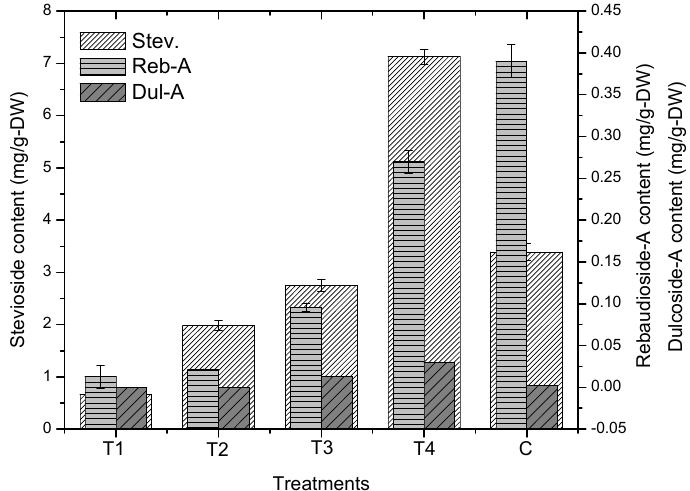
Figure 6. E ff ect of di ff erent GA 3 concentrations on production of Steviol glycosides. Data were collected from three independent experiments. Triplicate mean values along with standard errors (SE) are significantly di ff erent at p < 0.05.